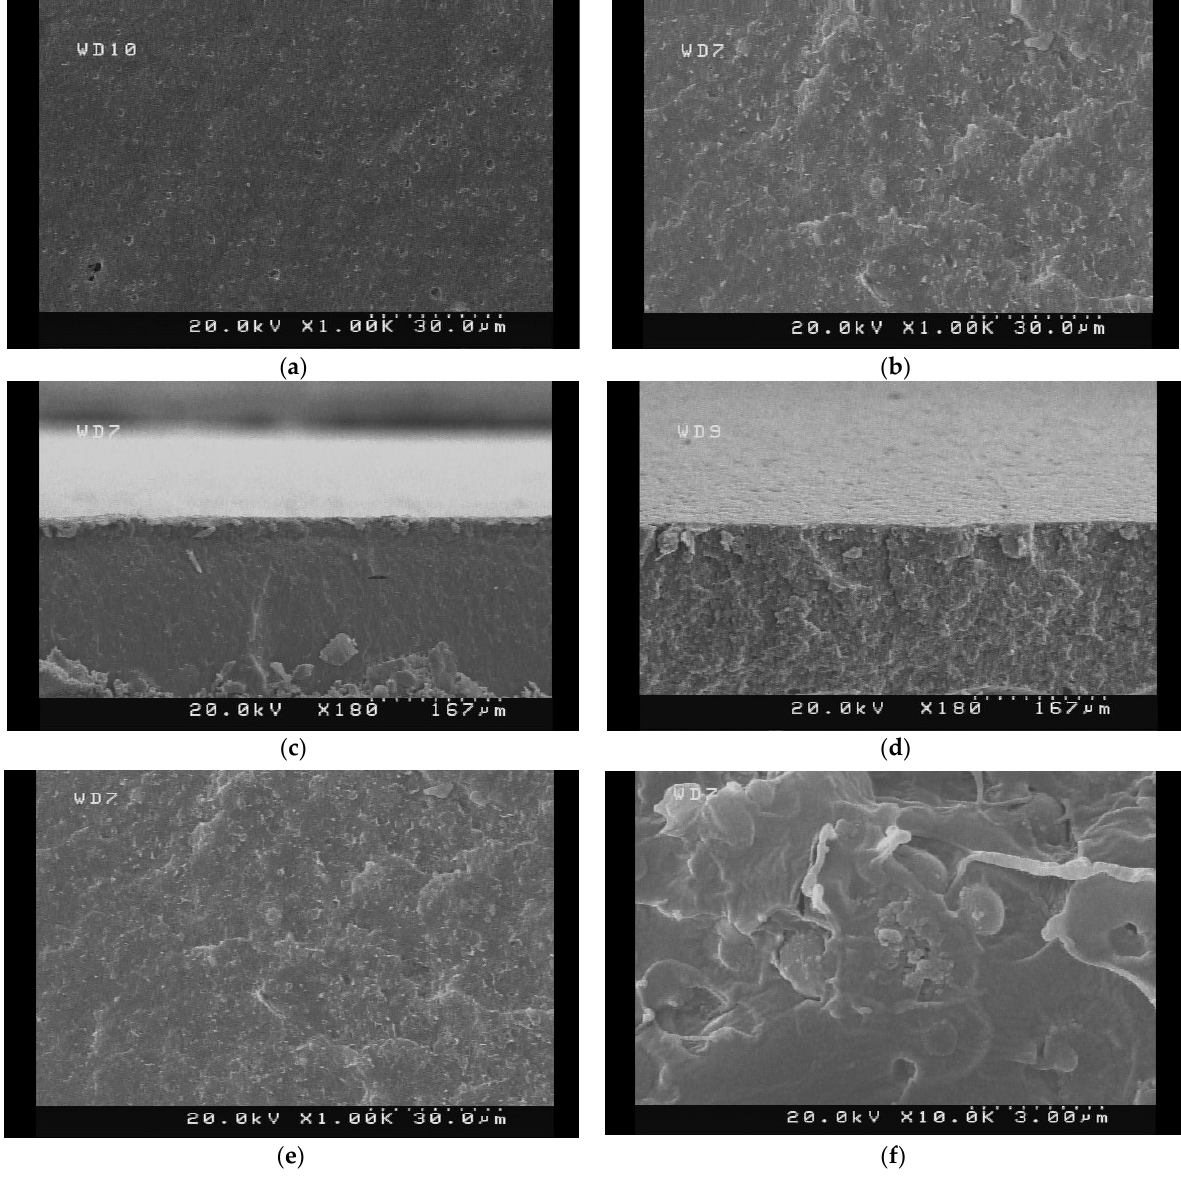
Figure 5. The SEM micrographs of the surface (( a ) PLA and ( b ) PLA ‐ WL ‐ 7 biocomposites), fracture surface (( c ) PLA and ( d ) PLA ‐ WL ‐ 7 biocomposites), and fracture surface of PLA ‐ WL ‐ 9 in two surface (( c ) PLA and ( d ) PLA-WL-7 biocomposites), and fracture surface of PLA-WL-9 in two different different magnifications (( e ) 1KX and ( f ) 10 KX). magnifications (( e ) 1KX and ( f ) 10